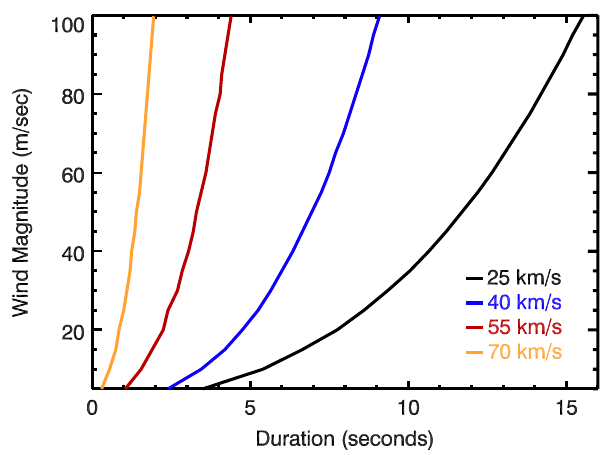
Fig. 6. A plot of trail duration versus wind speed for the cases of 4 different velocities and a 1.0µg meteor with 0 ◦ entry angle. Notice the influence that an increased magnitude in horizontal wind speeds has on a meteor’s plasma trail and its duration. The plot used data from simulations of the meteor trail durations of 4 identical mete- ors traveling at different speeds: 25kms − 1 , 40kms − 1 , 55kms − 1 and 70kms − 1 . Each of the meteors is simulated at different wind speeds. Note that meteor trail duration is directly linked to the mag- nitude of the wind